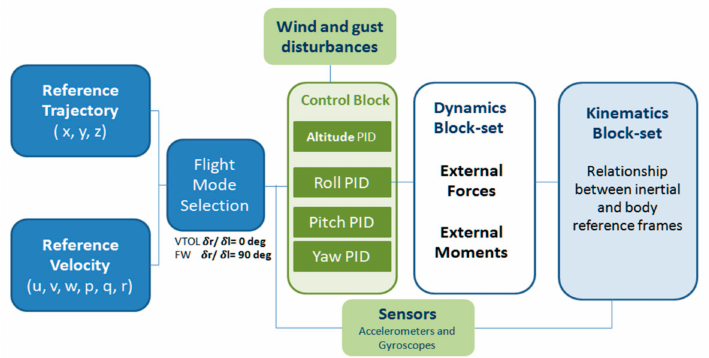
Figure 14. System model of hybrid VTOL tilt-rotor.